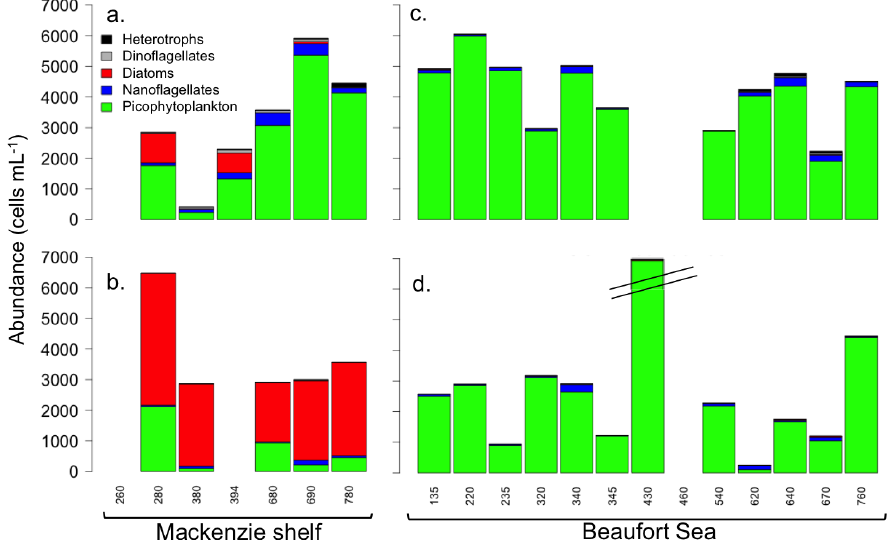
Figure 6. Abundance of five protist groups in (a, c) surface and at the (b, d) subsurface chlorophyll maximum (SCM) depth of the (a, b) Mackenzie shelf and (c, d) deep waters of the Beaufort Sea.